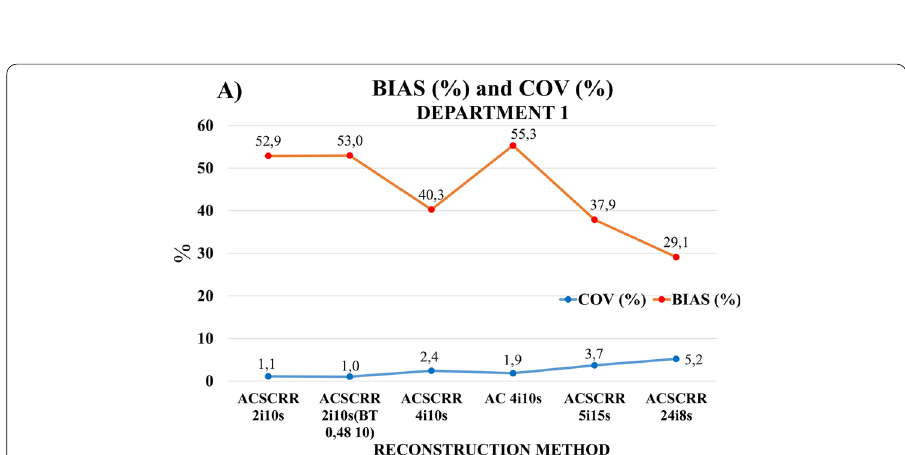
Fig. 6 BIAS and COV plot showing average BIAS values of spheres activity concentration and COV average values for background, in the NEMA/IEC NU2 Body Phantom cross sections reconstructed with 6 methods compliant with the White Paper GE Healthcare [12]. The calculations were made with the Q.Metrix program for images acquired with Discovery NM/CT 670 at Department